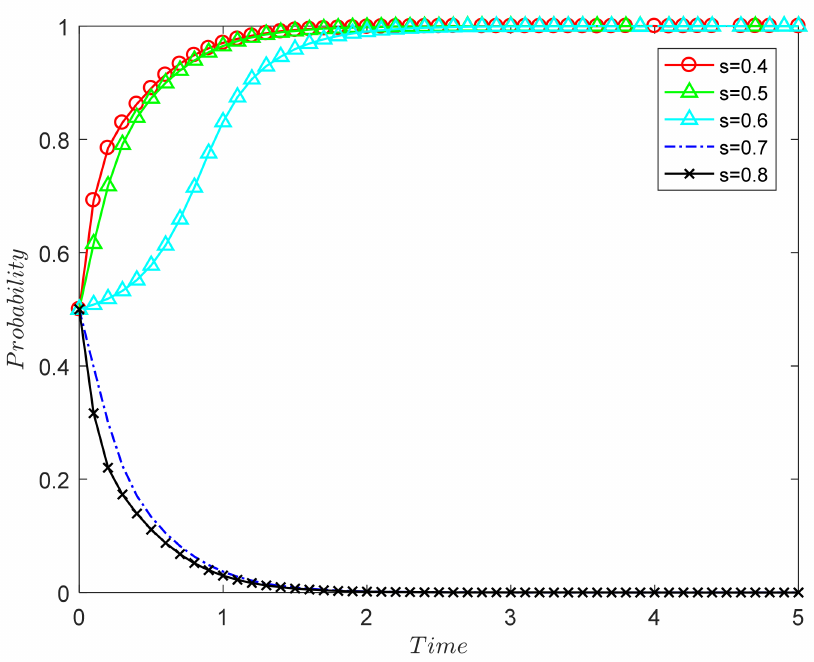
Figure 5. System evolution trajectory under different payment difference coefficients δ